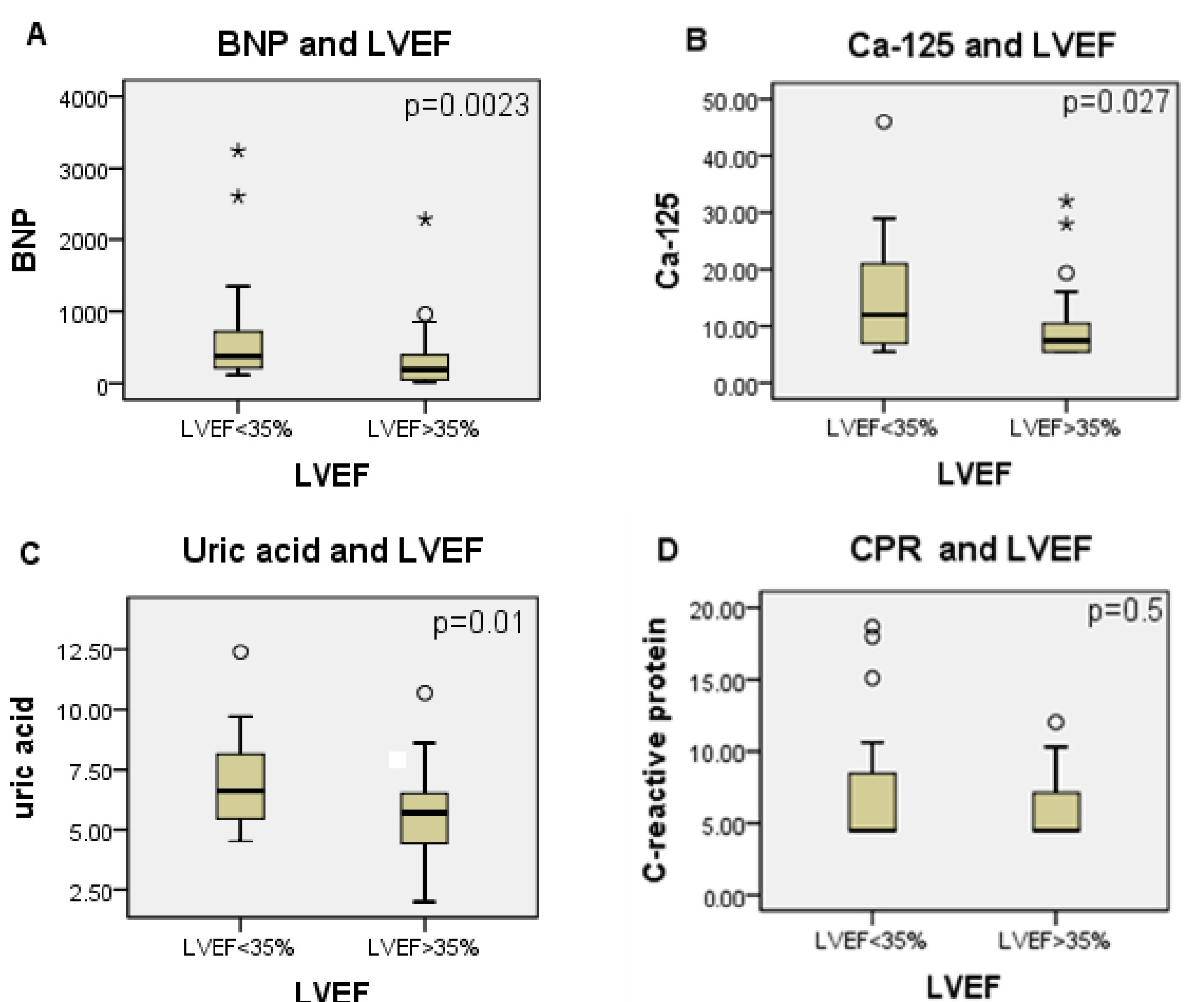
Figure 1. ( A ) BNP, Ca-125, uric acid, C-reactive protein serum levels and LVEF. ( B ) LVEF (patients grouped according to LVEF <35% or >35%) and BNP (bars represent median and 25th and 75th percentiles of circulating levels). ( C ) LVEF (patients grouped according to LVEF <35% or >35%) and Ca-125 (bars represent median and 25th and 75th percentiles of circulating levels). LVEF (patients grouped according to LVEF <35% or >35%) and uric acid (bars represent median and 25th and 75th percentiles of circulating levels). ( D ) LVEF (patients grouped according to LVEF <35% or >35%) and C-reactive protein (bars represent median and 25th and 75th percentiles of circulating levels). *, refers to group outliners; °, refers to group ouliners.